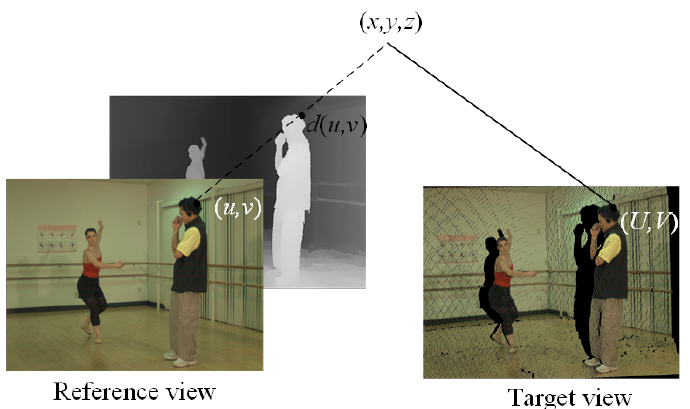
Figure 3. Profile of traditional 3D warping d ( u , v ) denotes the depth value in the depth map corresponding to the coordinates ( u , v ) .